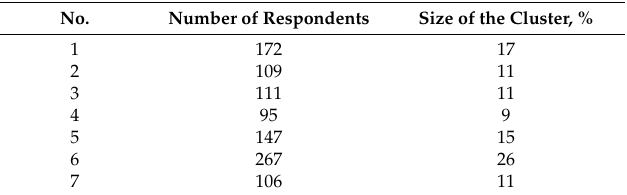
Table 6. Dimensions and shares of respondent’s (car owners) clusters.